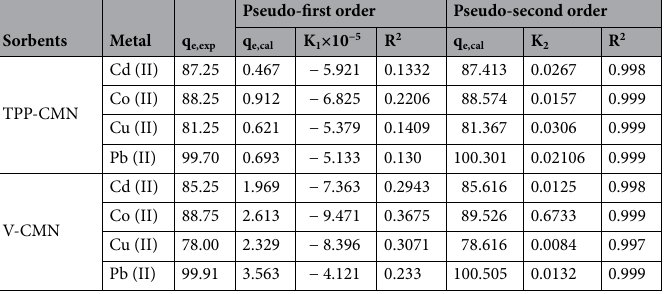
Table 1. Kinetic parameters for the adsorption Cd (II), Co (II), Cu (II), and Pb (II) ions.